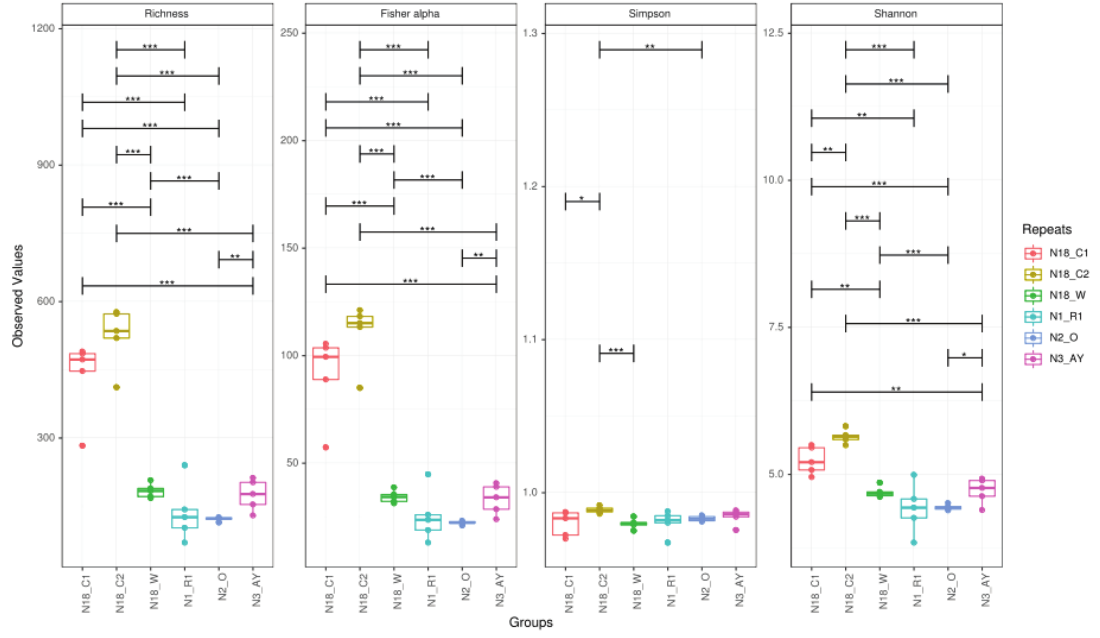
Figure 3: Alpha diversity of samples. Box-plots show value of indexes, lines show significant differences between pairs of samples